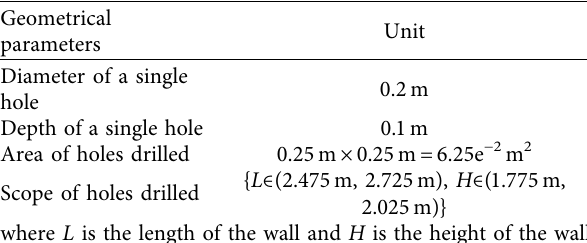
Table 2: The parameters of drilled holes.